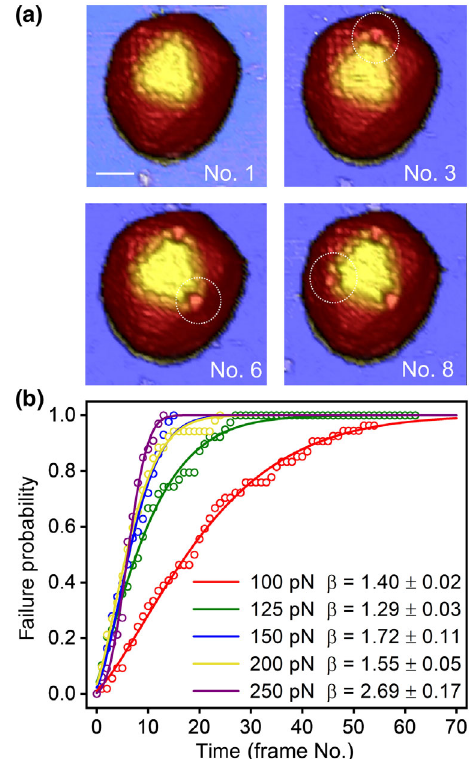
FIG. 2. Penton release analysis by cyclic mechanical stress assay. (a) Individual frames of one Ad5 particle at 150 pN (the scale bar is 37 nm; white circles mark the penton vacancies — see movie in Ref. [22]). (b) Penton release distribution at five forces. Dots represent the experimental data. For example, for 100 pN data (red), about 40% of the pentons remain on the capsid after 20 frames. Data fitting for a discrete Weibull distribution is shown with solid lines. See details in Fig.